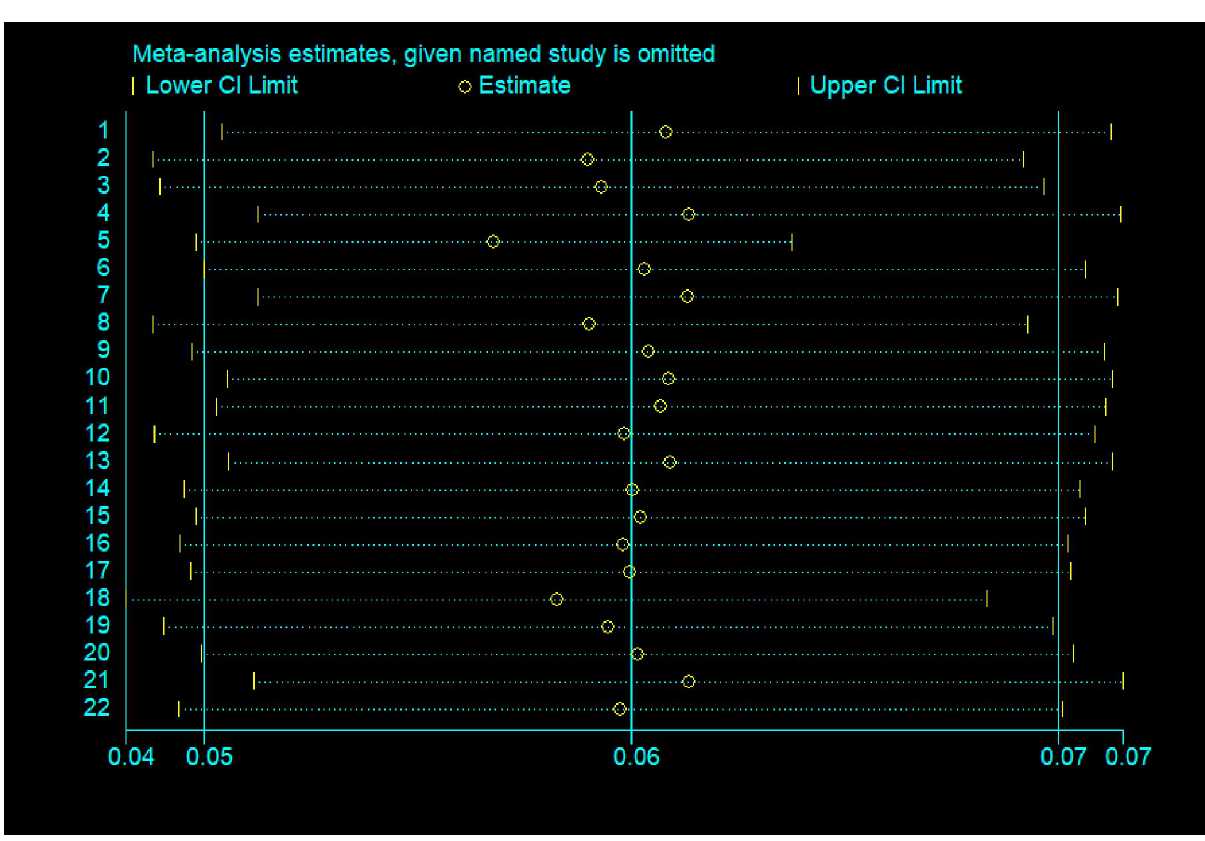
Fig 3. Showing the sensitivity analysis of meta-analysis on visual impairment due to refractive error in Ethiopia, 2021.